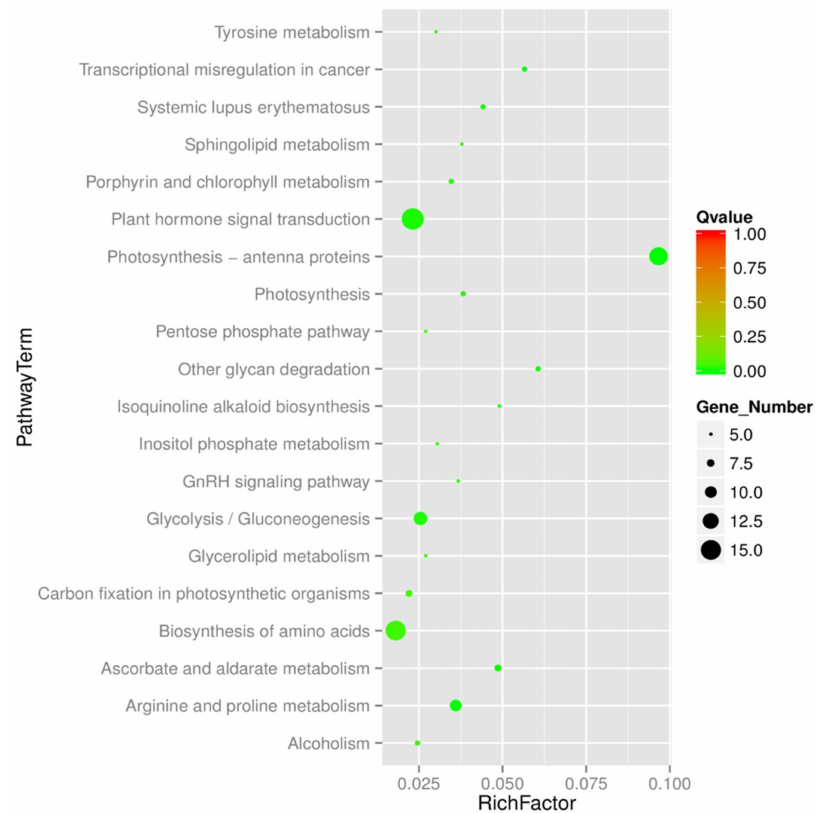
Figure 6. Gene enrichment of non-redundant unigenes. The longitudinal axis represents the different pathway and horizontal axis represents the Rich factor. The size of dots indicates the number of differentially expressed genes in this pathway and the color of the point corresponds to a different Qvalue